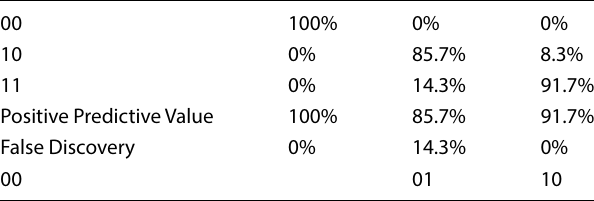
Table 3 Confusion Table for testing dataset based Burg